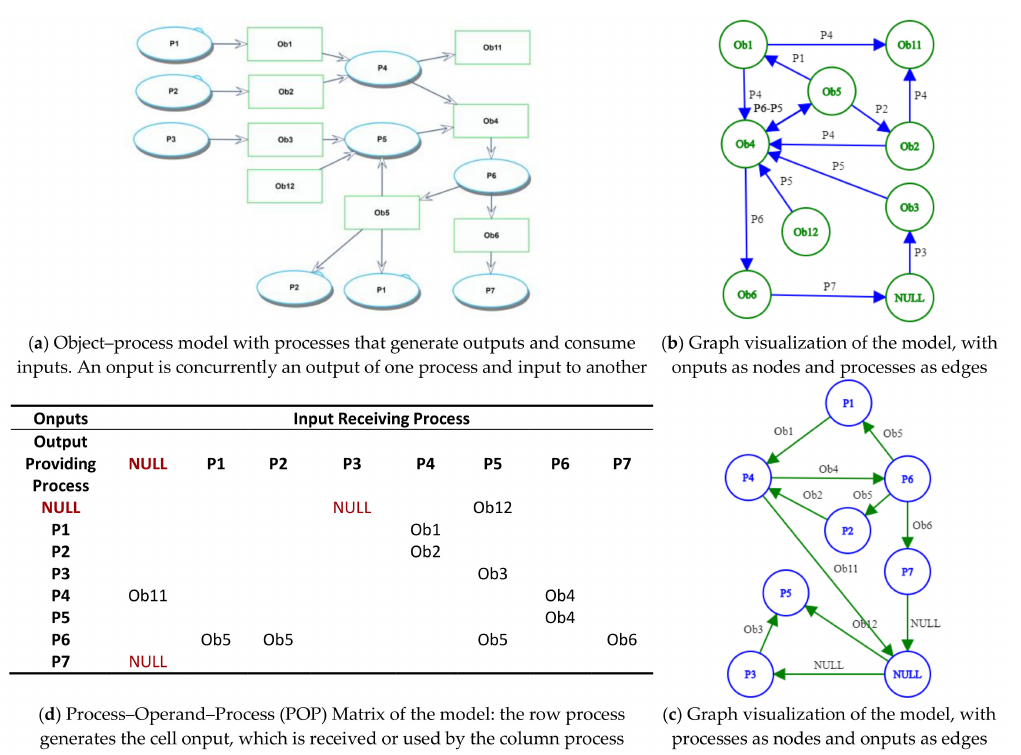
Figure 11. OPM model with processes and onputs ( a ), shown in three additional renditions: ( b ) an onput-on-node/process- on-edge graph, ( c ) a process-on-node/onput-on-edge graph, and ( d ) a process-to-process onput exchange matrix. NULL processes and onputs (in all renditions) serve as placeholders for missing or partial relations, like an input without a source process (Ob12), a process without an input (P3) or without an output (P7), and an output without a target process (Ob11). Both graph visualizations were rendered using https://csacademy.com/app/graph_editor/ (accessed on 3 December